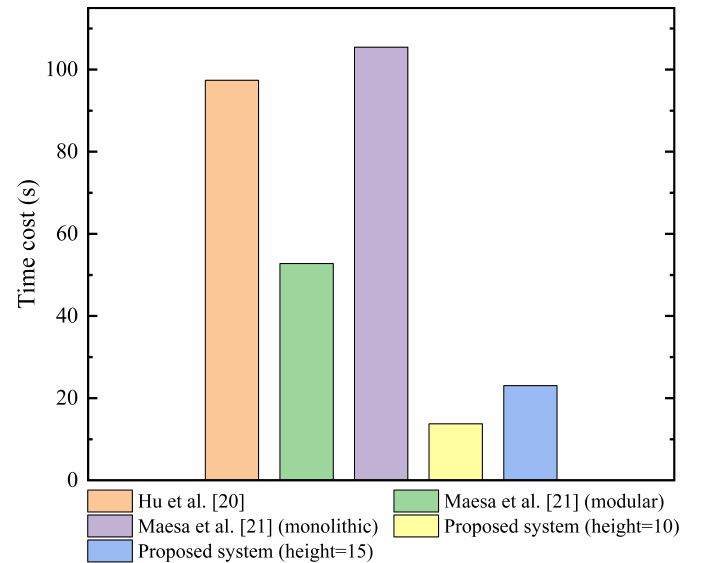
Figure 10. Time cost (s) of access control authorization process in the low-traffic environment, where the number of concurrent requests is set to